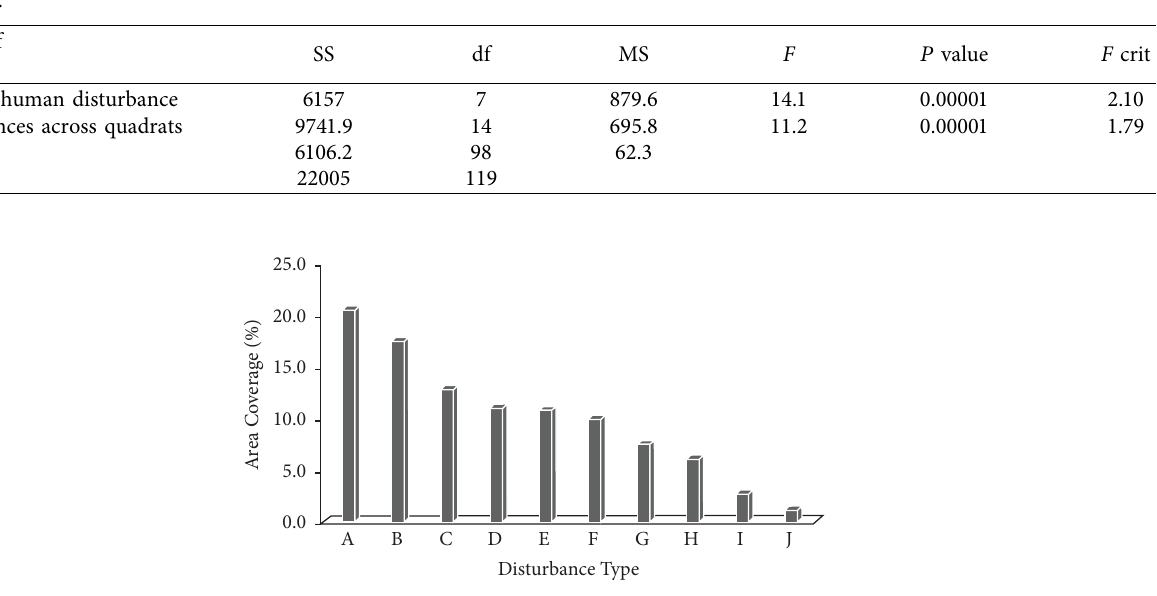
Figure 7: Te contribution of the amount of each type of disturbance that afect the church forest; where A � gathering area (Mahiber), B � logging, clearing, C � grazing, D � grave and grave houses, E � buildings, F � trails, G � plantation (exotic species), H � rocky, I � plantation (native species), and J � wind fallen